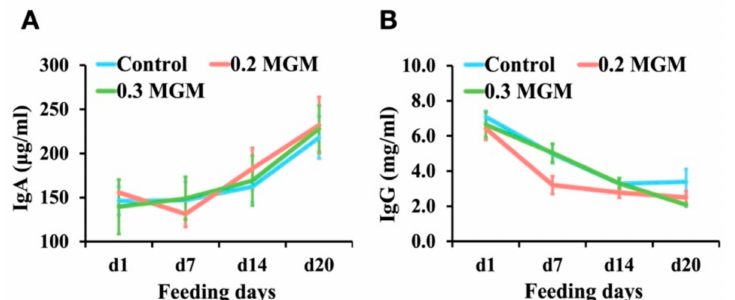
Figure 3. Effects of MGM-P supplementation on blood immunoglobulin levels in weaned piglets. Blood was collected on d1 before the provision of feed with MGM-P on the day of weaning. Values are expressed as mean ± SEM; n = 8. Different lowercase letters on the right side of the nodes indicate significant differences ( p < 0.05; Tukey HSD test). ( A ) the changes of the immunoglobulin A concentration; ( B ) the changes of the immunoglobulin G concentration.